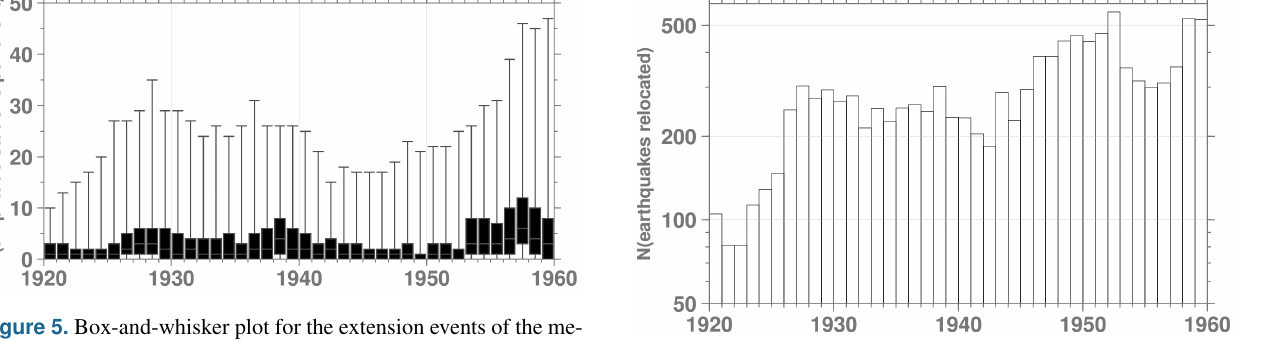
Figure 6. Annual number of the relocated extension events between 1920 and 1959. See text for